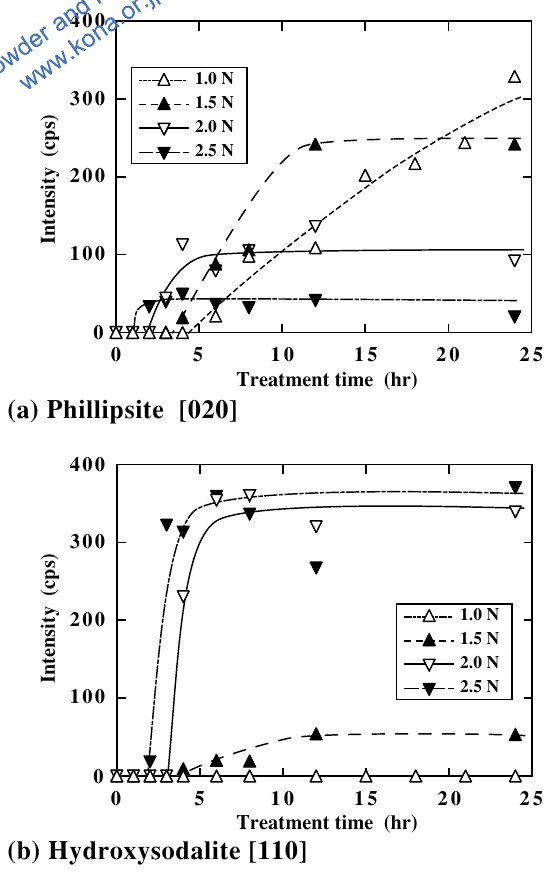
Fig. 4 Change in XRD peak intensity of products with treatment time for various NaOH concentrations.